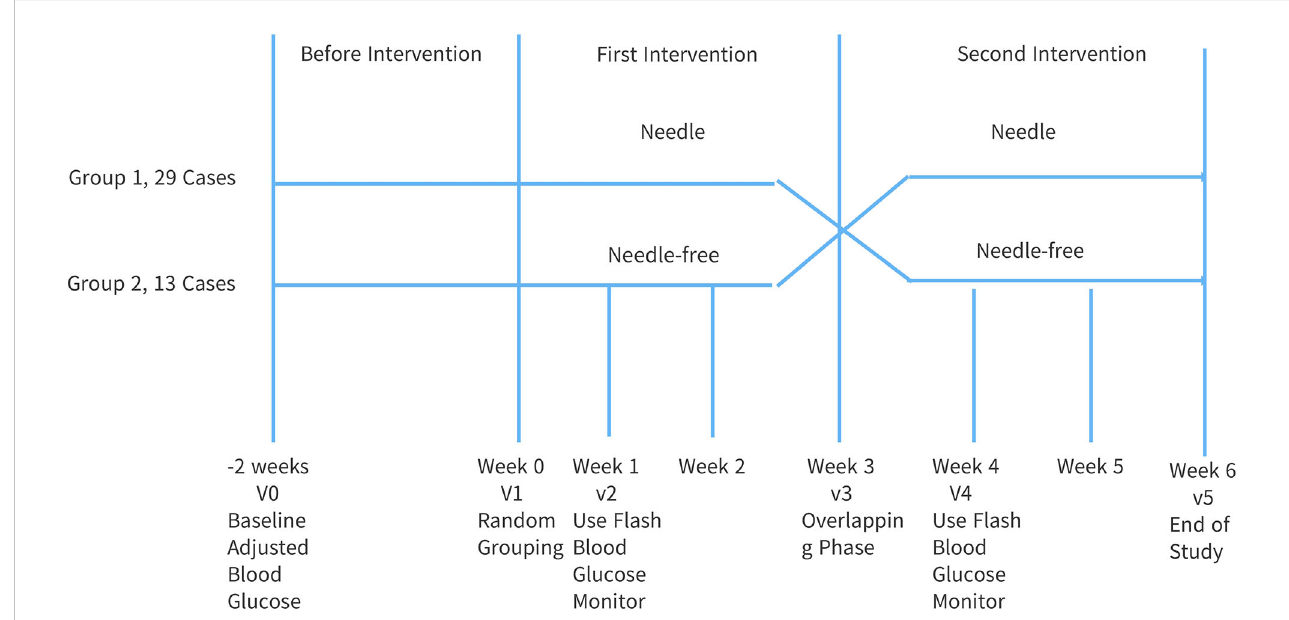
FIGURE 1 Flow chart of cross